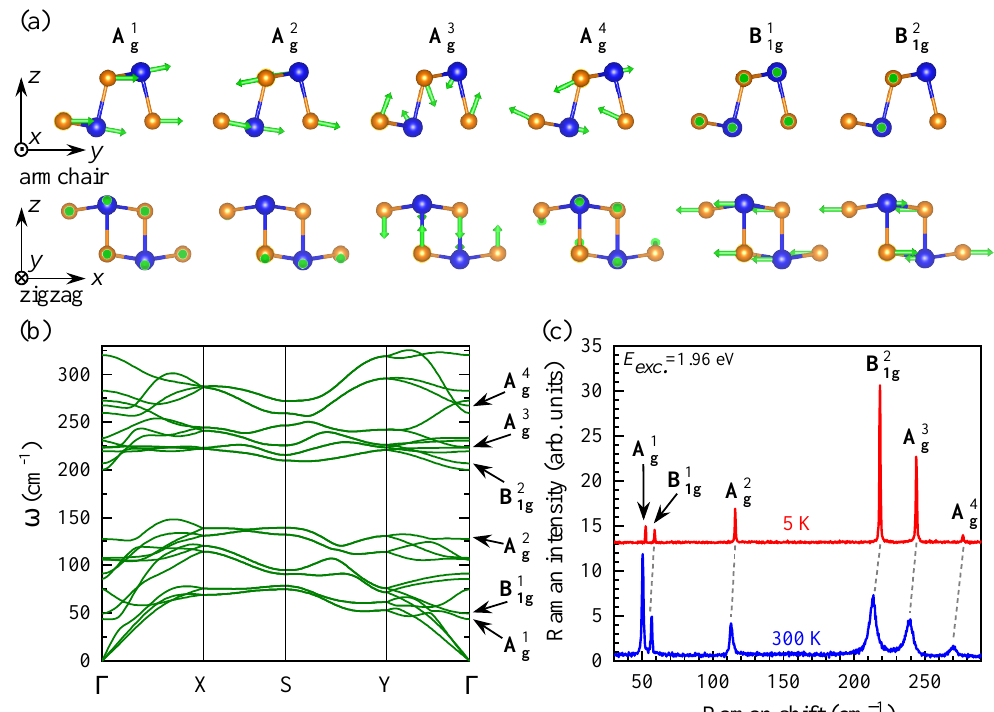
Figure 4. ( a ) Atom displacements (green arrows) for the Raman-active modes. Axes indicate two view perspectives: armchair and zigzag directions. ( b ) The calculated phonon dispersion of GeS. ( c ) RS spectra measured on GeS at low ( T = 5 K) and room ( T = 300 K) temperatures. The spectra are vertically shifted for